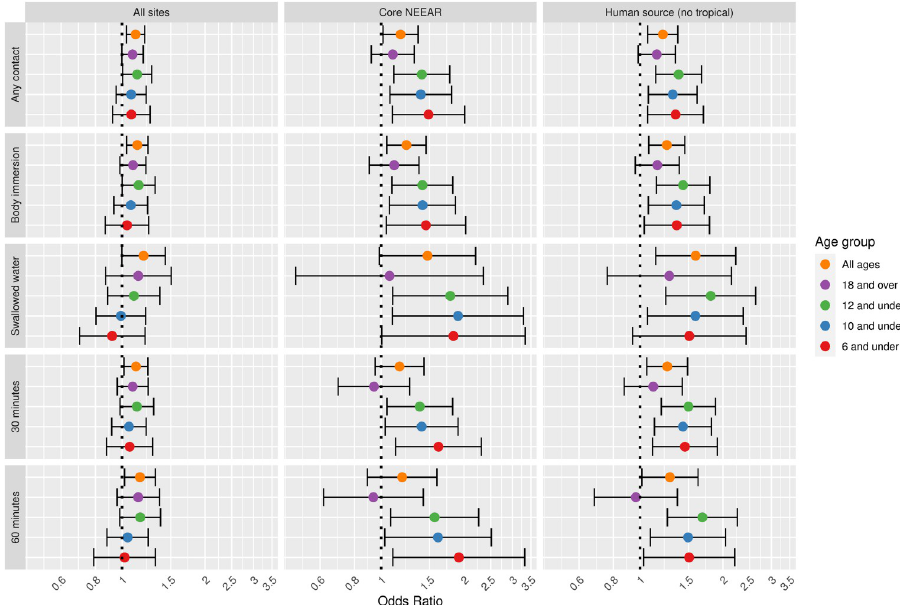
Fig 4. Odds ratios for diarrhea among swimmers associated with a 1-log10 increase in Enterococcus